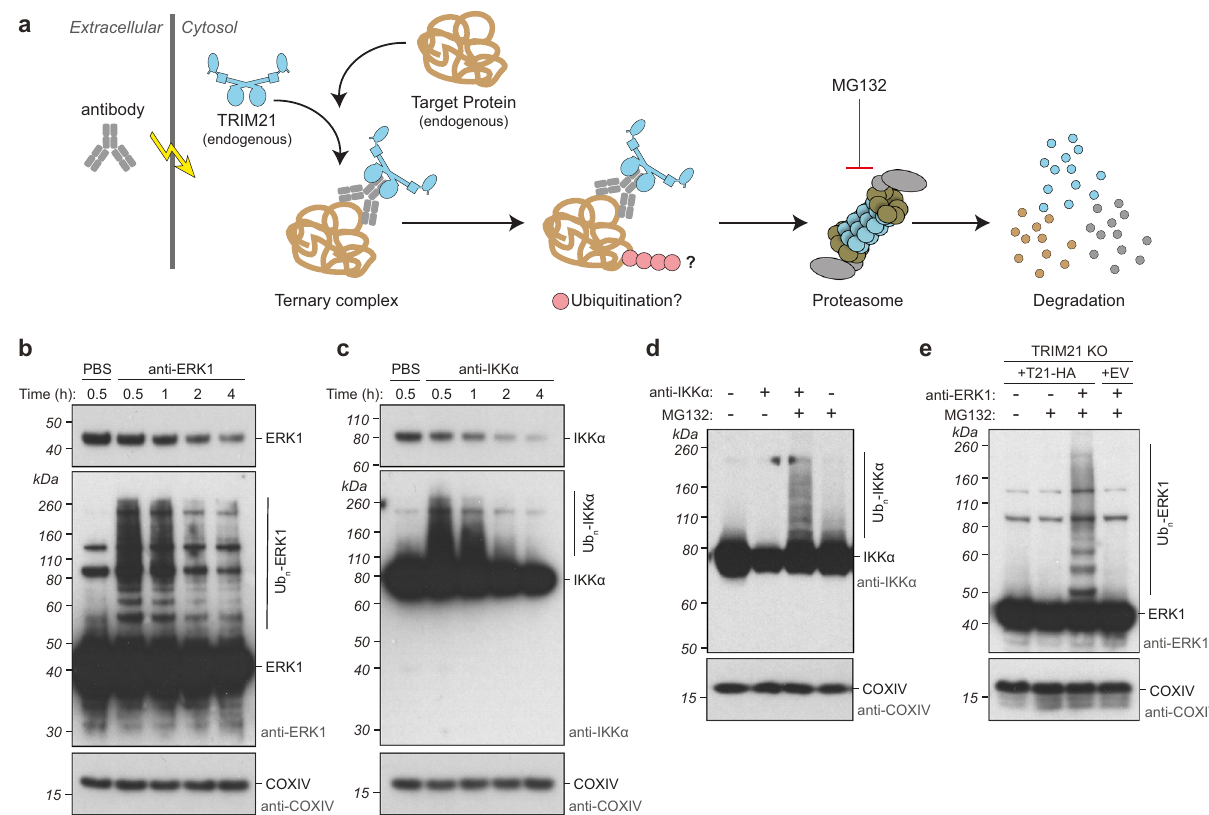
Fig. 5 | Substrate ubiquitination parallels substrate degradation during Trim- Awayincells.a SchematicshowingTrim-Awayexperimentinwhichantibodiesare electroporated into cells expressing endogenous TRIM21. Ubiquitination and degradation are then monitored in the presence or absence of proteasome inhi- bitorMG132. b , c RPE-1cellswereelectroporatedwithPBSoranti-ERK1antibody( b ) or anti-IKK α antibody ( c ) and whole cell lysates harvested at the indicated times after electroporation for immunoblotting. Short exposures show degradation of substrates. Long exposures reveal substrate ubiquitination followed by